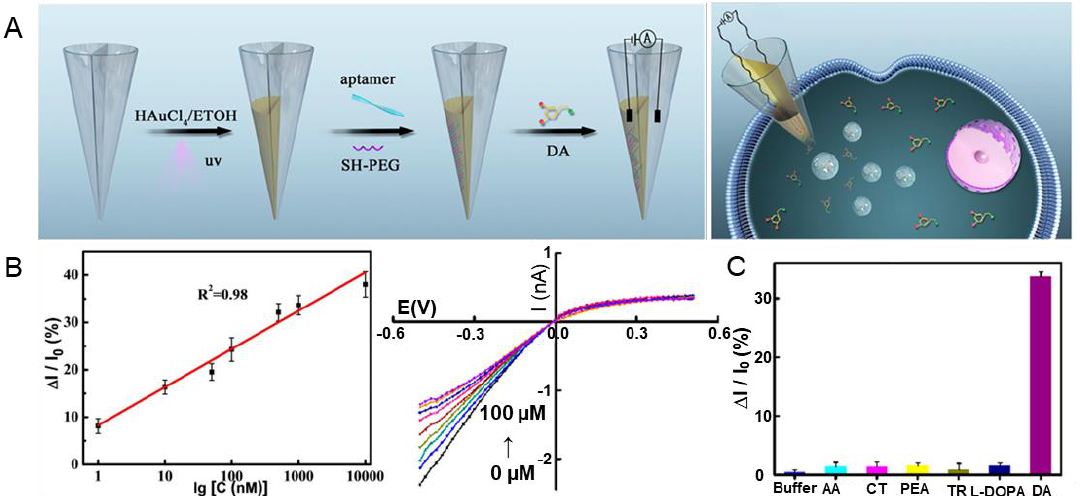
Figure 2. Gold-based dual-nanopore aptamer sensors for DA detection. ( A ) Schematic illustration of the fabrication process of a gold-based aptamer sensor. ( B ) Linear I-V curve indicating the linear range and LOD of DA, respectively. ( C ) Selectivity of the fabricated aptamer sensor. With permis- sion from [58]. Copyright 2022, ACS. HAuCl 4 , Gold (III) chloride trihydrate; ETOH, ethanol; UV, ultraviolet; SH, thiol; PEG, polyethylene glycol; DA, dopamine; AA, ascorbic acid; CT, catechol; PEA, phenethylamine; TR, tyrosine; L-DOPA, 3,4-dihydroxyphenylalanine.